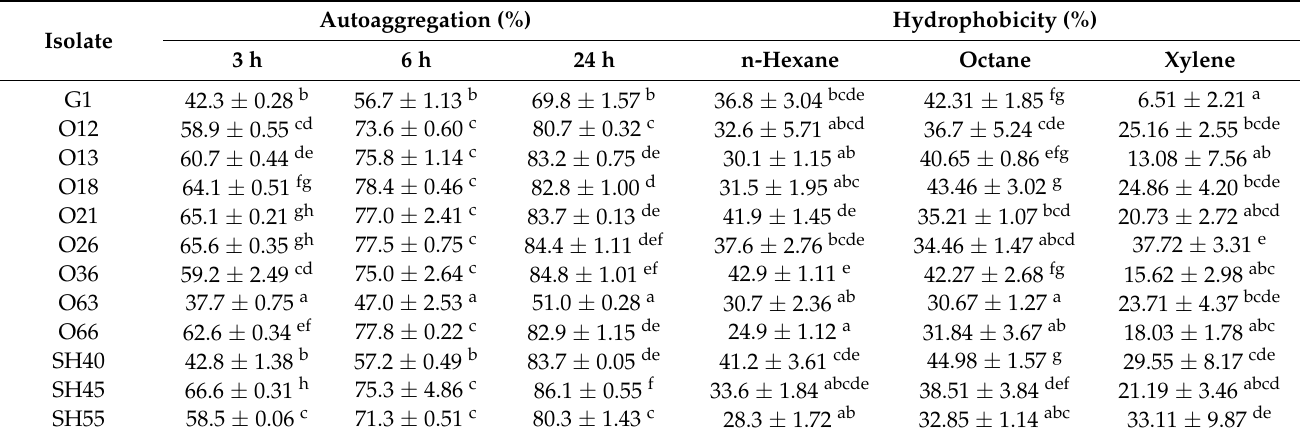
Table 3. Autoaggregation (%) and hydrophobicity (%) of 12 potential probiotic yeast